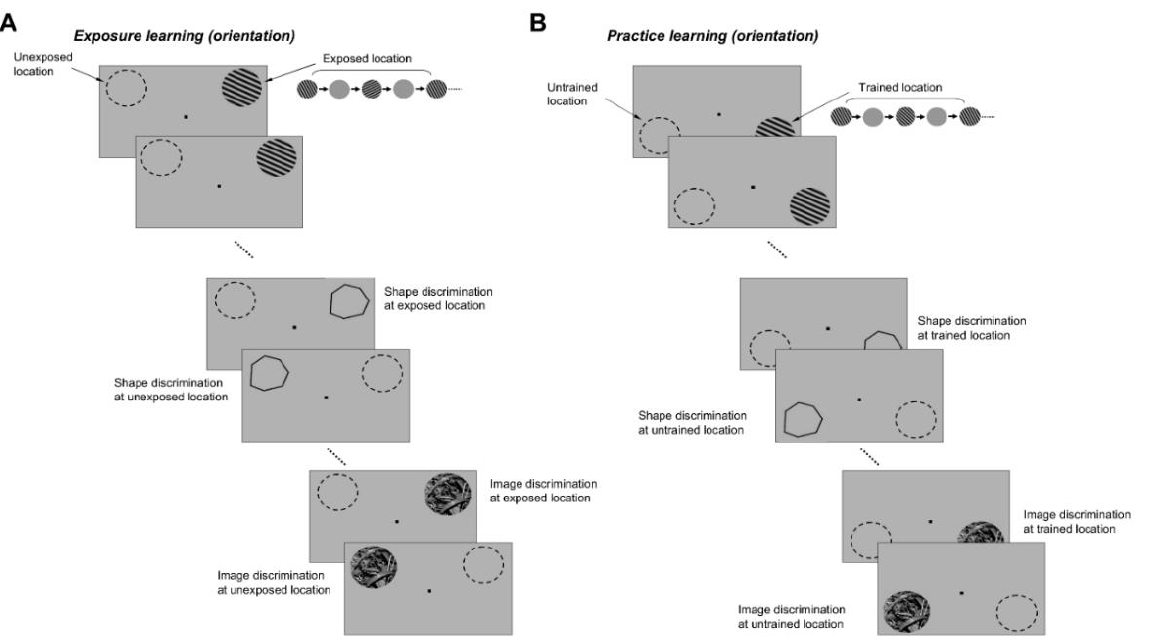
Figure 7. Stimulus generalization experiments. ( A ) Exposure learning. Subjects were successively exposed to two pairs of orthogonal orientations, 60°/150° and 30°/120°, 12 sessions for each pair. After completion of the orientation exposure sessions, subjects were required to discriminate shapes and natural scenes. Discrimination tests were performed at both exposed and unexposed locations by successively flashing shapes or natural images that were slightly tilted relative to each other. ( B )